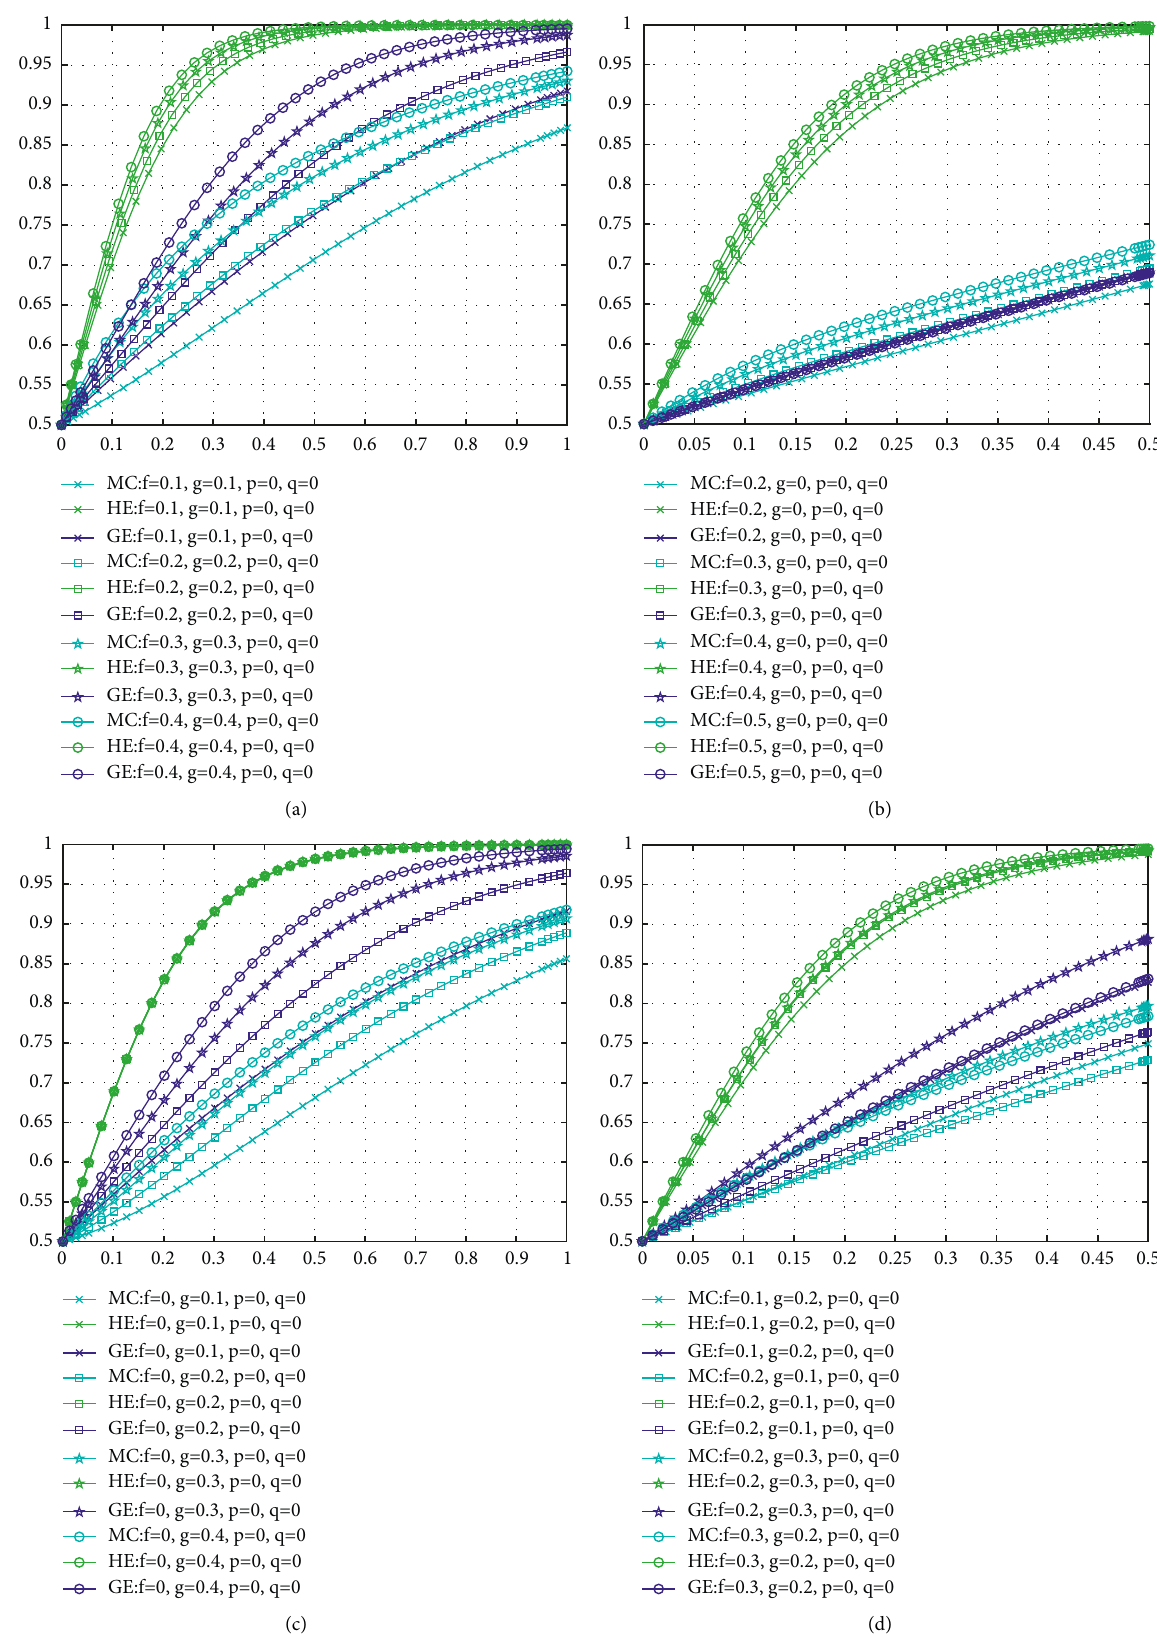
Figure 9: The evolution result of the penalty rate change. (a) f,g are equal changes. (b) Only f changes. (c) Only g changes. (d) f, g are not equal